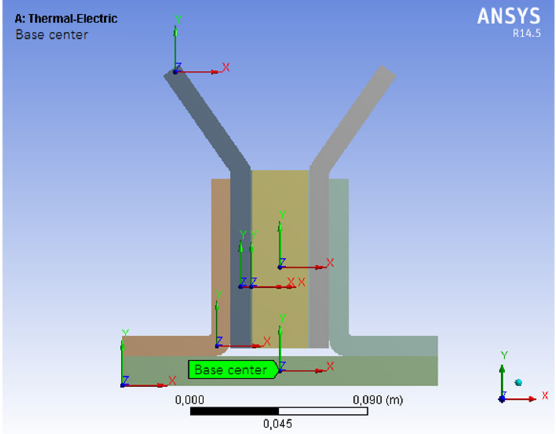
Figure 7. A view of the temperature probes in the middle of the high ‐ current contact. Tables were created based on temperature values collected from temperature probes.